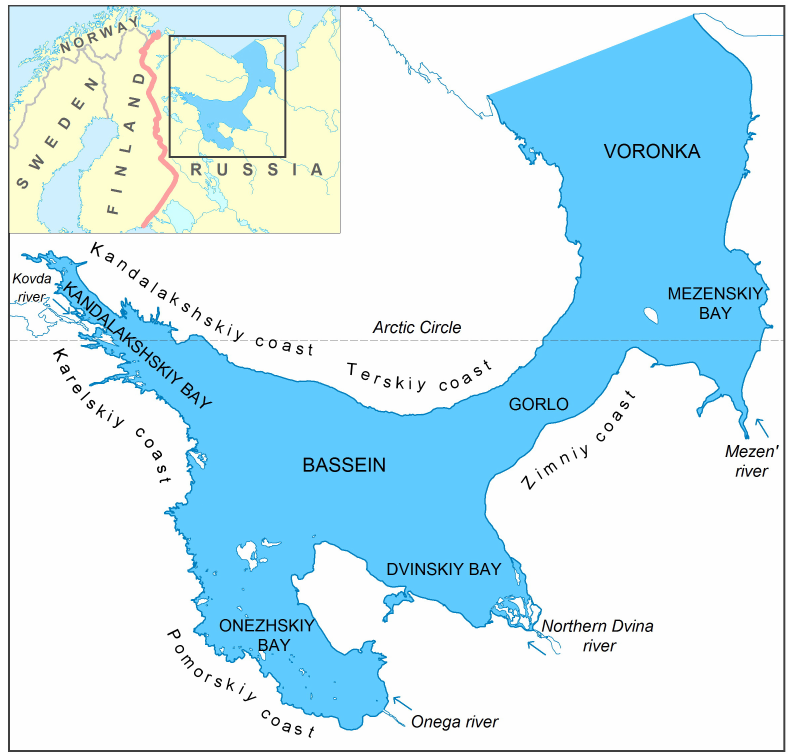
Figure 1. Parts and coasts of the White Sea. Areas of the parts are (thousand km 2 ): Voronka 24.6, Gorlo 10.2, Mezenskiy Bay 5.6, Bassein 21.8, Dvinskiy Bay 9.6, Onezhskiy Bay 12.3, Kandalakshskiy Bay